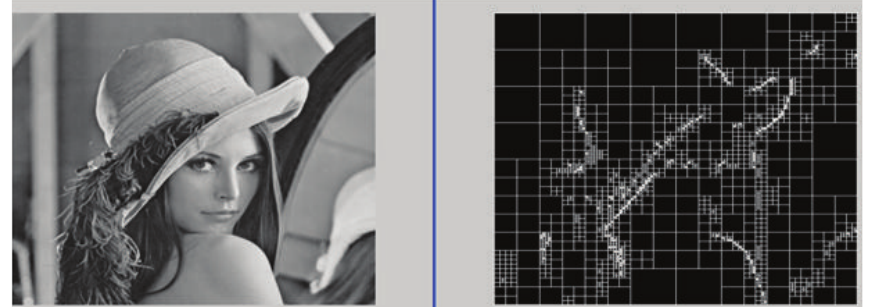
Figure 2: Quadtree decomposition of Lena.